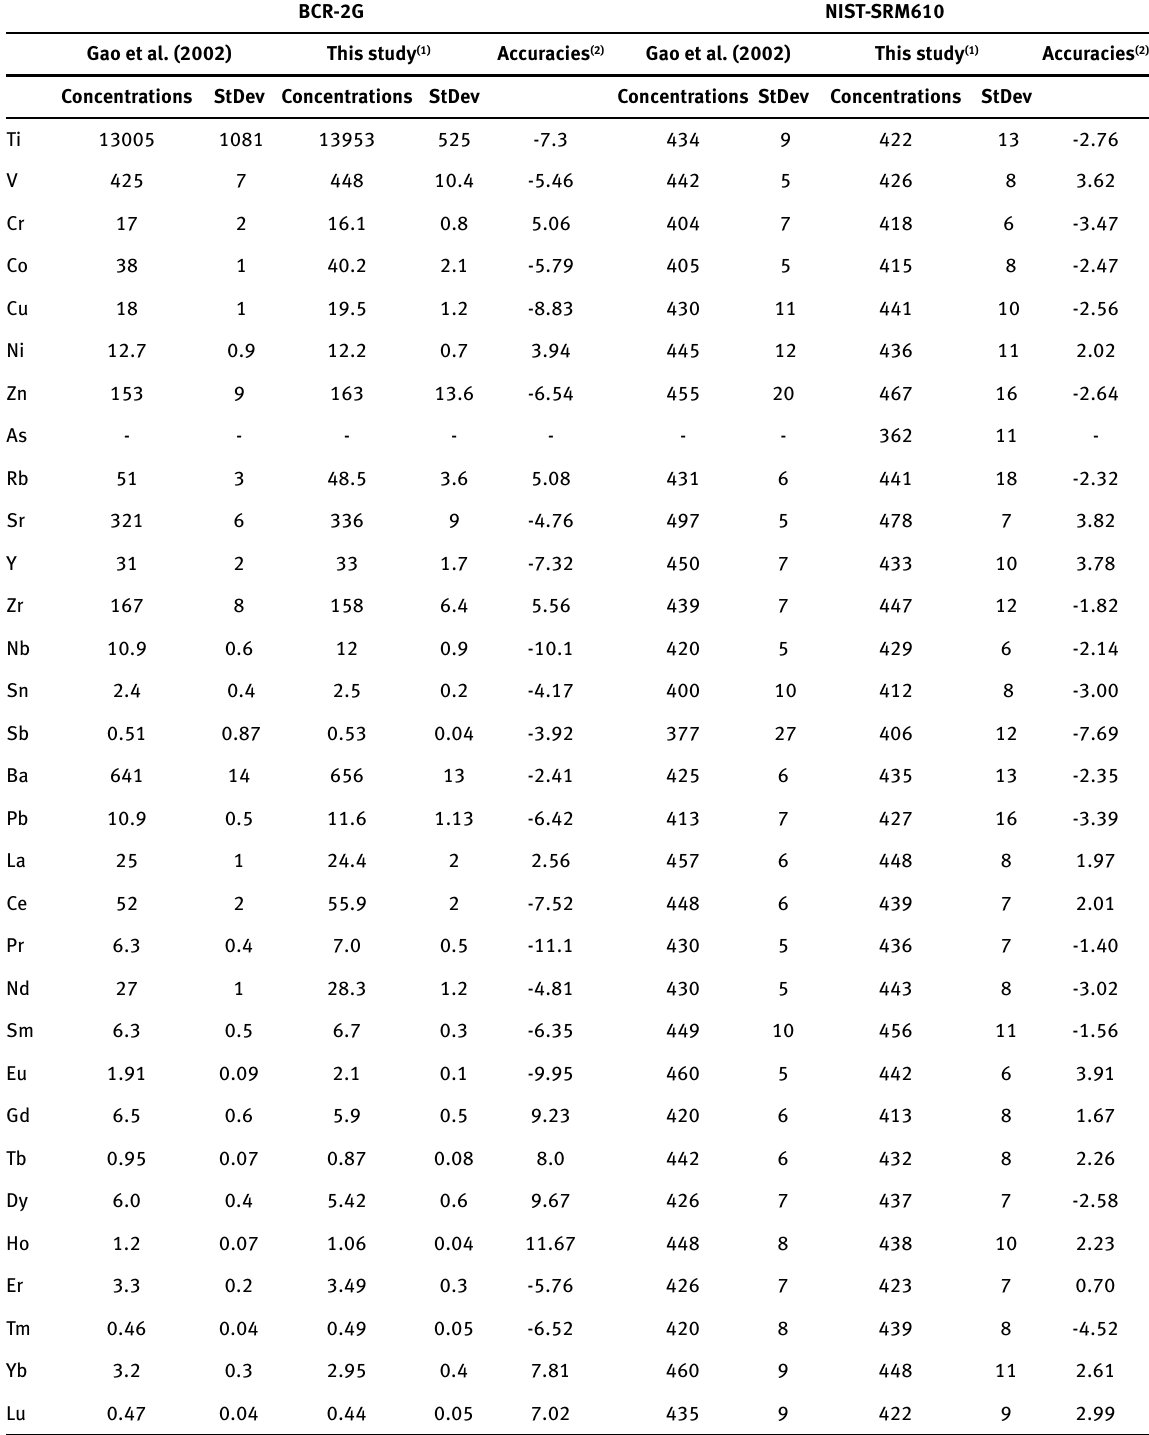
Table 4: Analyses by LA-ICP-MS of BCR-2G and NIST SRM 610 standard glass (in ppm); StDev=standard deviation. Comparison between literature data (Gao et al., 2002) and results from the present